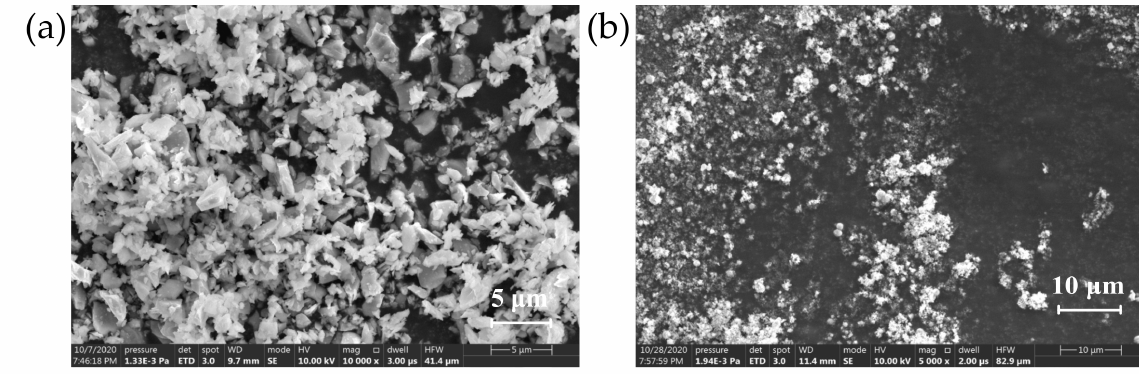
Figure 3. Electron microscopy of micron and nanometer SiC particles. ( a ) 1.5 µ m β -SiC; ( b ) 50 nm β